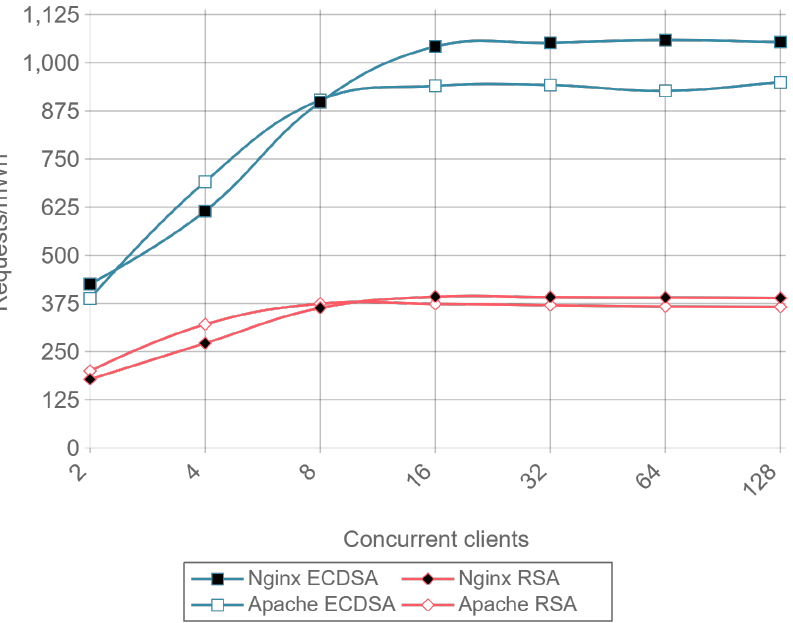
Figure 15. Server-side concurrent clients versus requests/mWh for Apache2 and Nginx with 512 bytes of payload for Elliptic Curve Digital Signature Algorithm (ECDSA) and Rivest–Shamir–Adleman